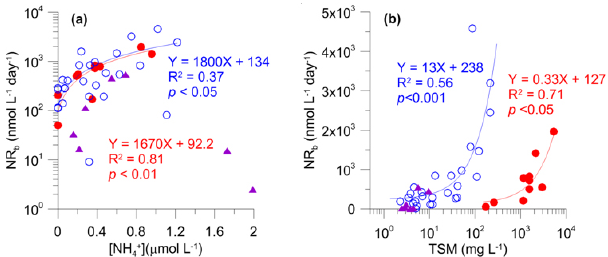
Fig. 4. Scatter plot of bulk ammonia oxidation rate against (a) am- monium, and (b) TSM along the Chang Jiang River plume and the Qiantang River mouth. The symbols indicate the data from the river mouth ( • ), inner plume ( ◦ ), or outer plume ( N ). The blue and red curves indicate the linear regression in log–log scale for the inner plume and the river mouth, respectively. Linear regression line for all data points is shown. Note that the X axis in (a) and Y axis in (b) are in log 10